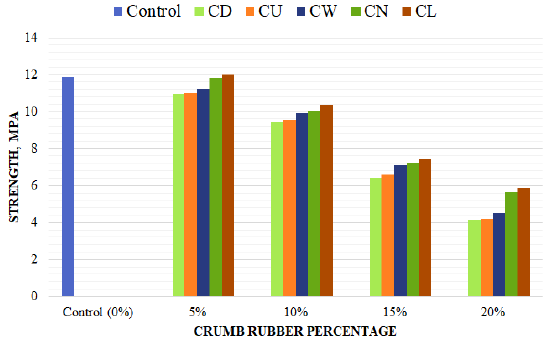
Figure 8. Compressive strength at 7 days.